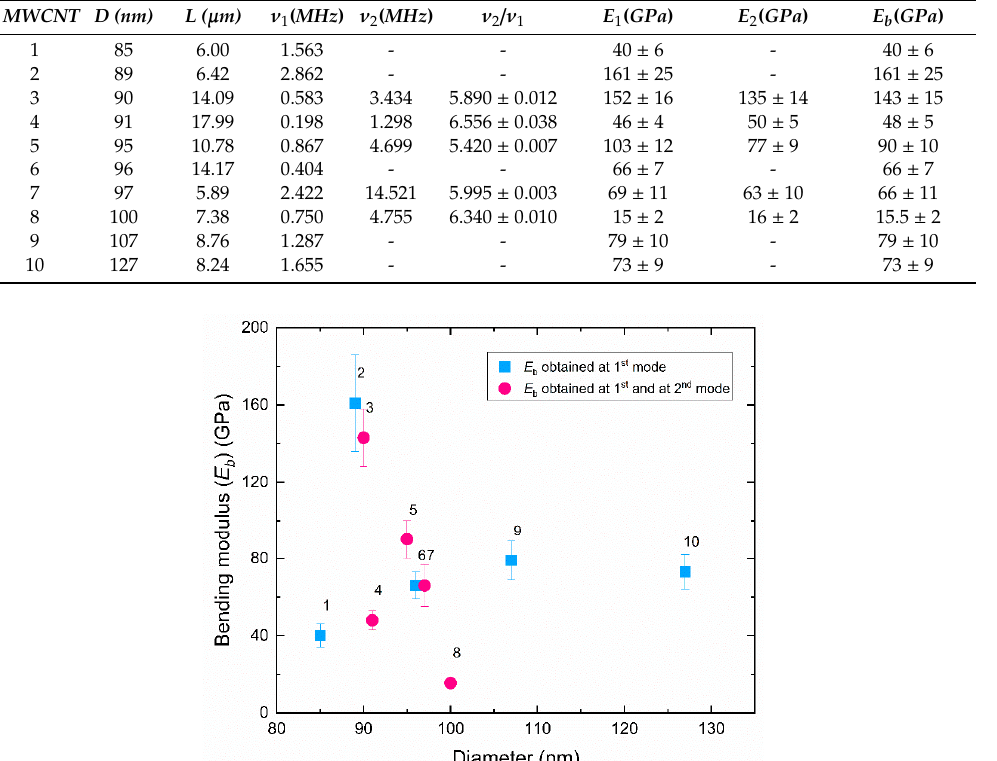
Figure 8. Bending modulus values E b vs. outer diameter D for NM-401 MWCNTs from Table 2. In this plot one can clearly see the assorted values of bending modulus for the nanotubes tested.